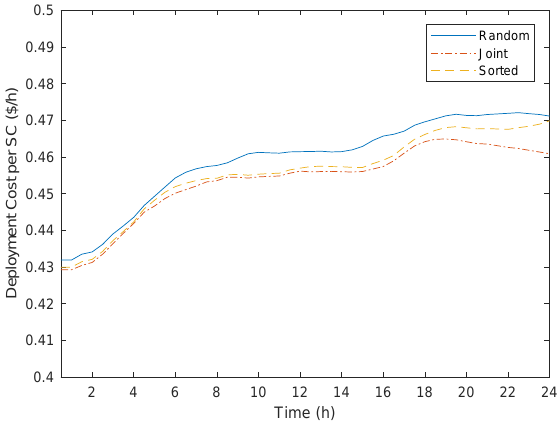
Figure 5. Impact of initial solution in Tabu